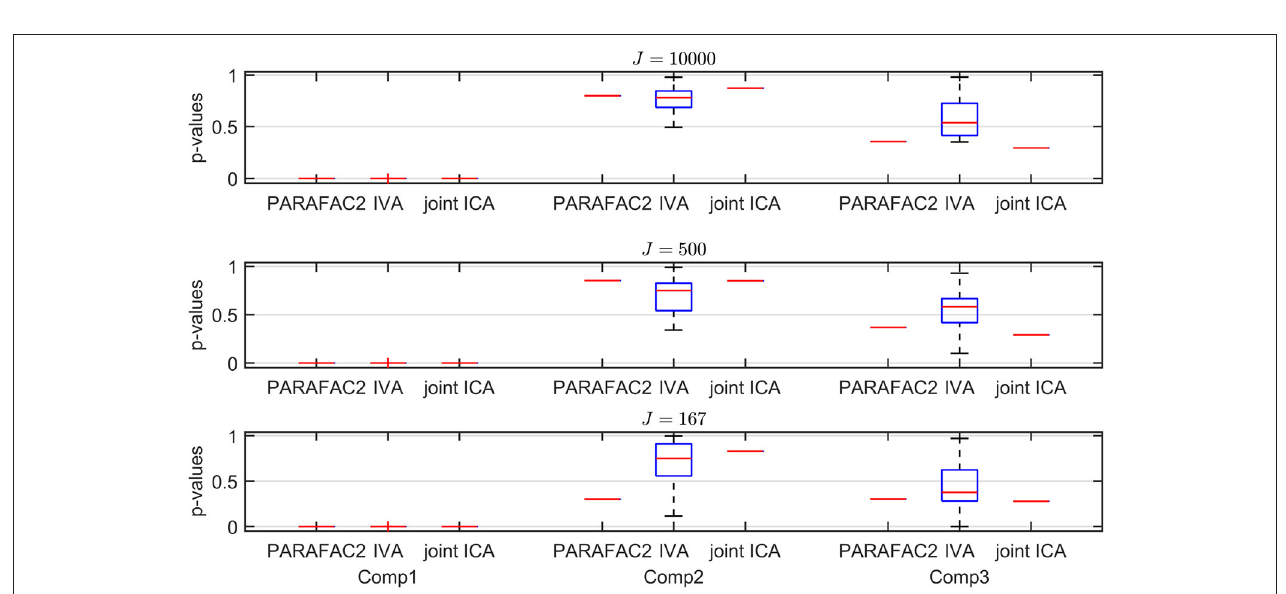
FIGURE 4 | Case 1a. Evolving components ( B k or S k , for k = 1,..., K ) captured by each method after fixing the scaling and permutation ambiguity: (A) PARAFAC2, (B) IVA, (C) joint ICA. All methods recover the underlying evolving components accurately.